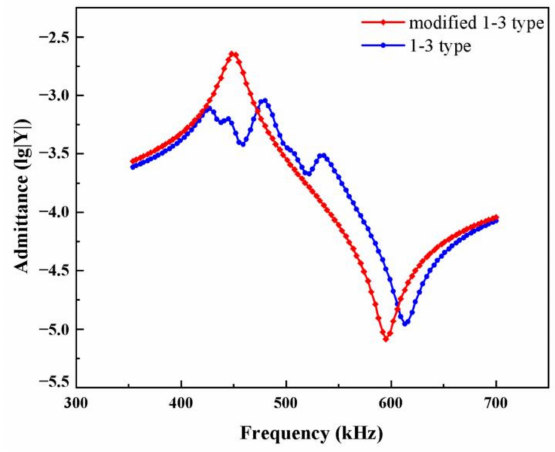
Figure 14. Decoupling effect of modified 1-3 piezoelectric composite.